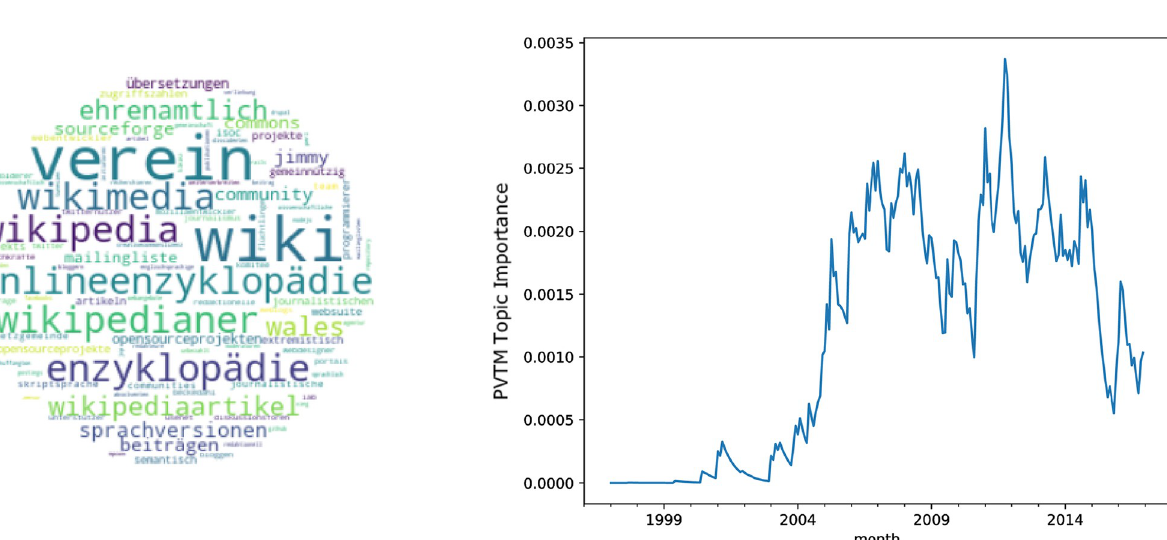
PLOS ONE | https://doi.org/10.1371/journal.pone.0226685 January 22,